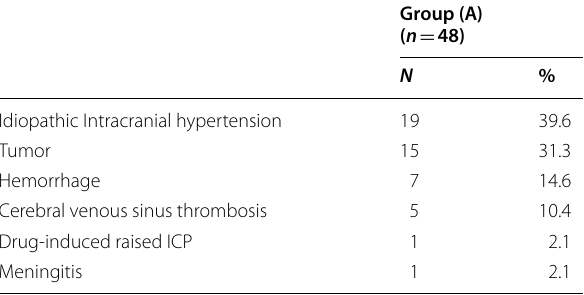
Table 3 Causes of papilledema in group (A)